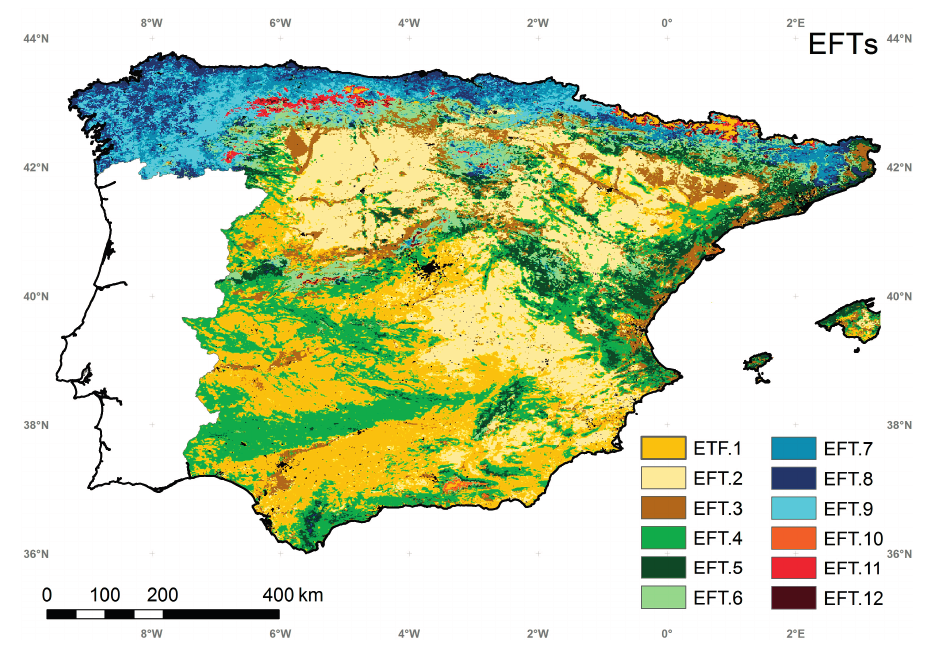
Figure 8. Distribution of ecosystem functional types (EFTs) in